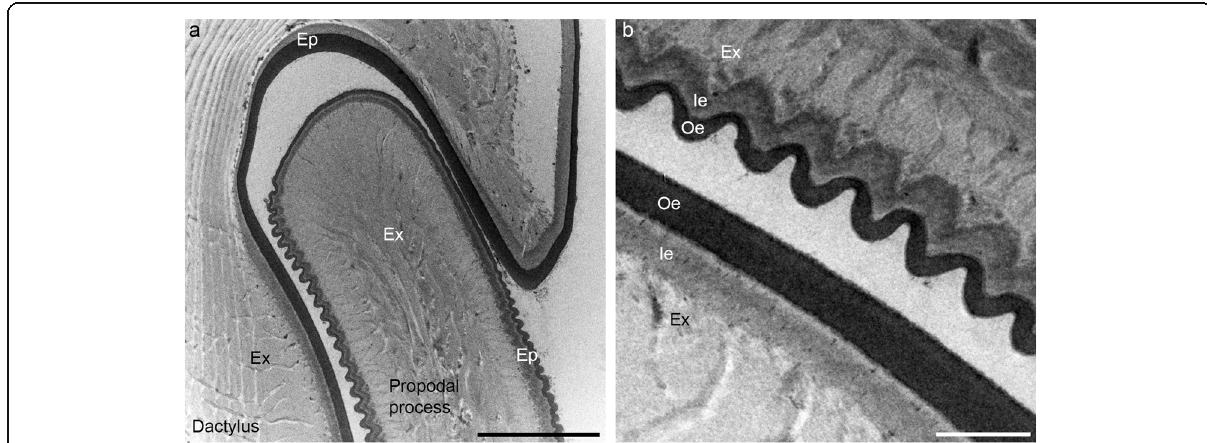
Fig. 6 Ultrastructure of the contact surfaces in the propodus-dactylus joint. a Transmission electron micrograph of the propodal process inside the groove of the dactylus. The ridges on the propodal process are formed predominantly by the epicuticle (Ep), while its interior consists of the exocuticle (Ex). The epicuticle covering the groove of the dactylus is smooth and thicker. b Detail of the sliding surfaces of the propodus (top right) and the dactylus (bottom left). The denser outer epicuticle (Oe) covers the lighter inner epicuticle (Ie). The exocuticle (Ex) is visible in the innermost parts of the ridges on the propodus, while the ridges consist mostly of the epicuticle. The smooth epicuticle of the dactylus is thicker. Scale bars: 5 μ m (a), 1 μ m